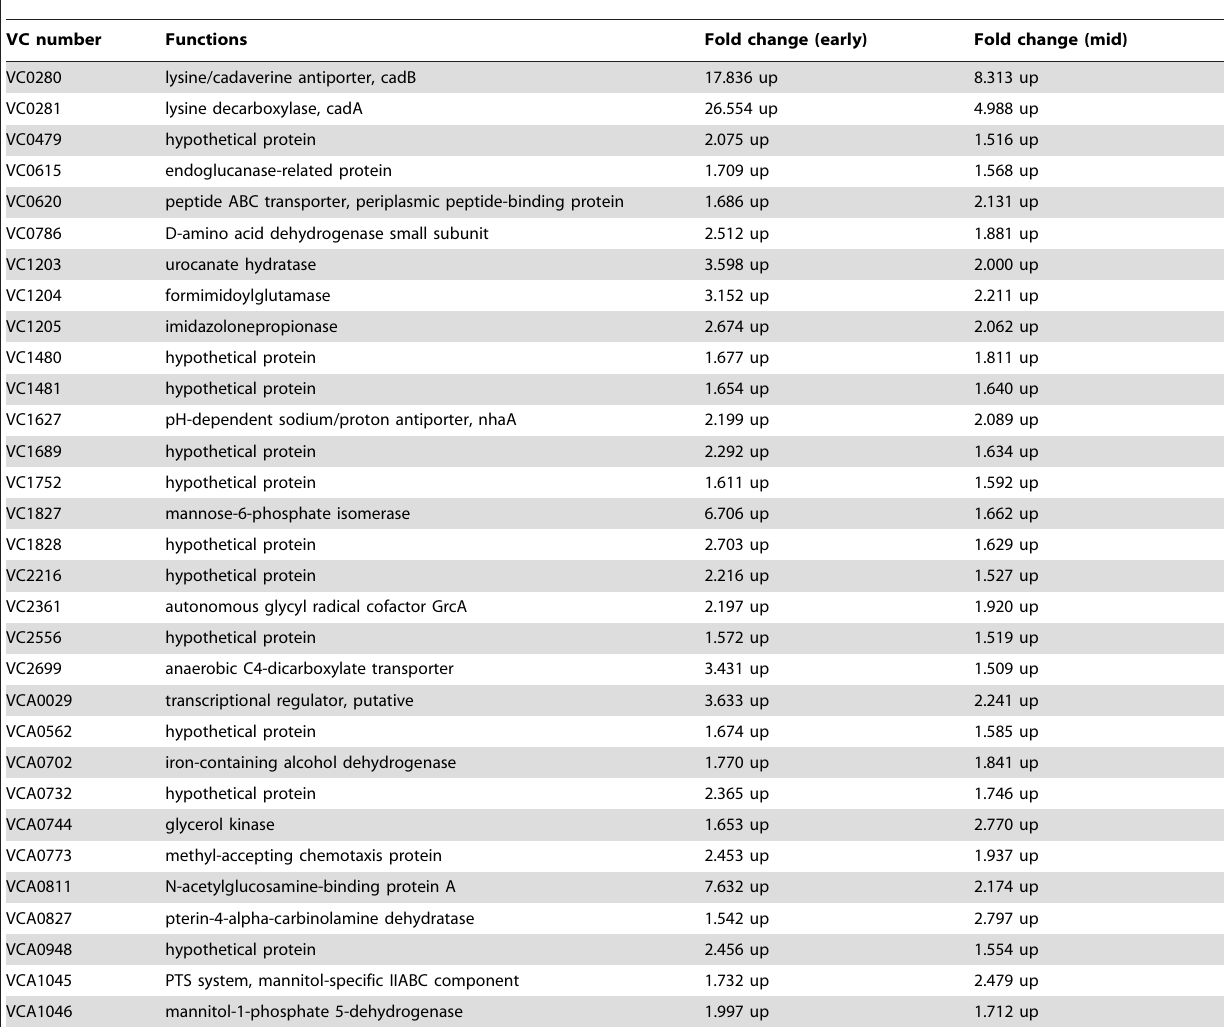
Table 1. Genes up-regulated in the D nqrA-F mutant based on microarray analysis.